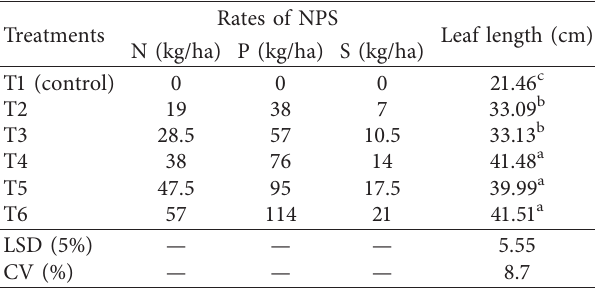
Table 2: Effect of different rates of NPS on leaf length. Treatments